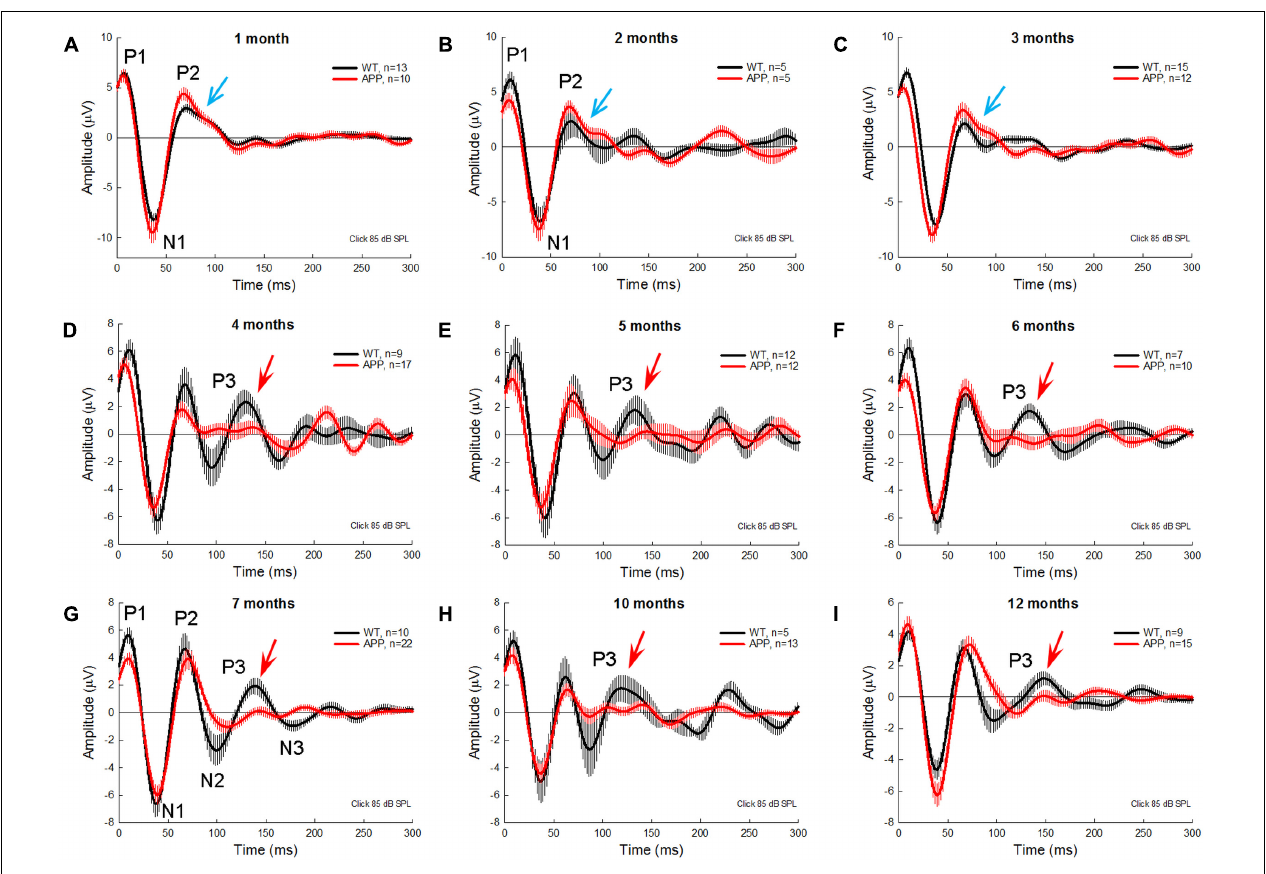
FIGURE 3 | AECP traces were recorded from APP/PS1 AD mice at different ages. WT littermates served as control. Red and black traces represent averaged AECP traces recorded from APP/PS1 AD mice and WT mice, respectively. Error bars represent SEM. Mouse age is indicated in each penal. N is the mouse number. Blue arrows indicate a notch at the descending side of peak P2 in AD mice at 1–3 months old. Red arrows indicate the P3 peak clearly visible in WT mice but not in AD mice after 3 months old.